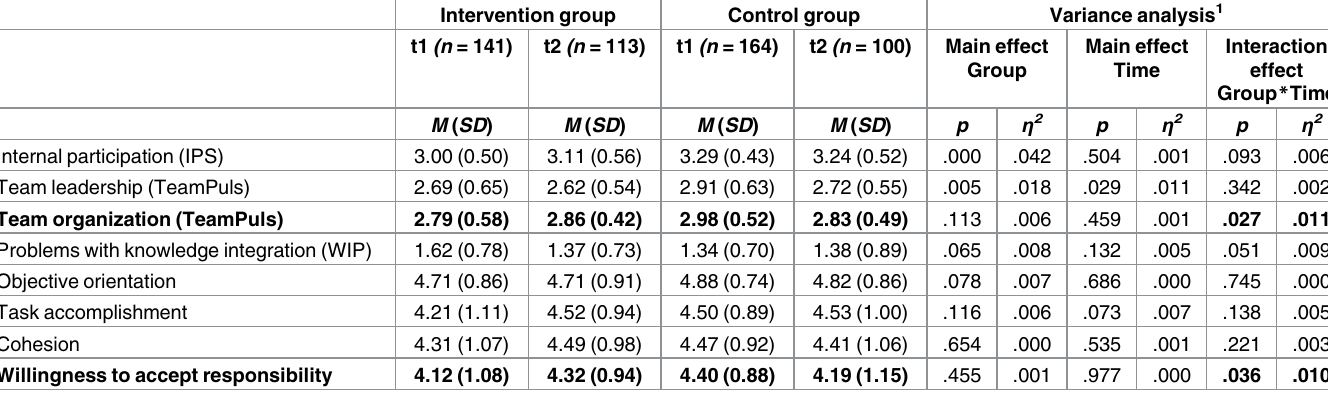
Table 7. Staff survey:Univariate comparisons of the patient orientation and teamwork variables for group and time of data collection.